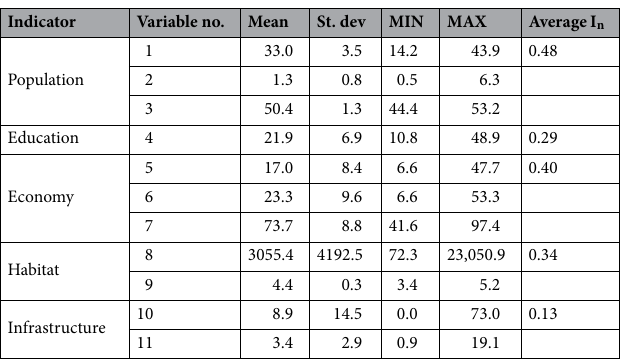
Table 3. Descriptive statistics of variables used in the social vulnerability